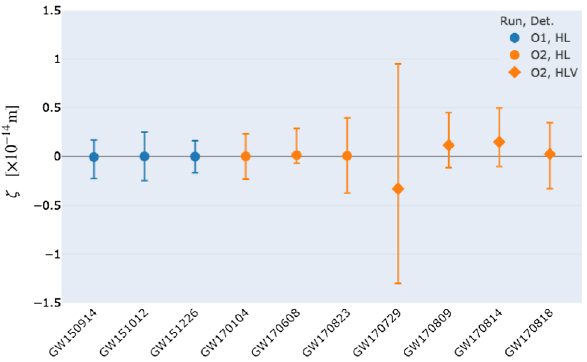
Fig. 2 Constraints on the CPT-violating parameter ζ from the ten sig- nals of BBHs in the LIGO-Virgo catalog GWTC-1 [36]. A capital H/L/V denotes a LIGO-Hanford/LIGO-Livingston/Virgo detector. A dot/square denotes HL/HLV. Blue/orange color denotes O1/O2. The error bars denote 90% confidence interval